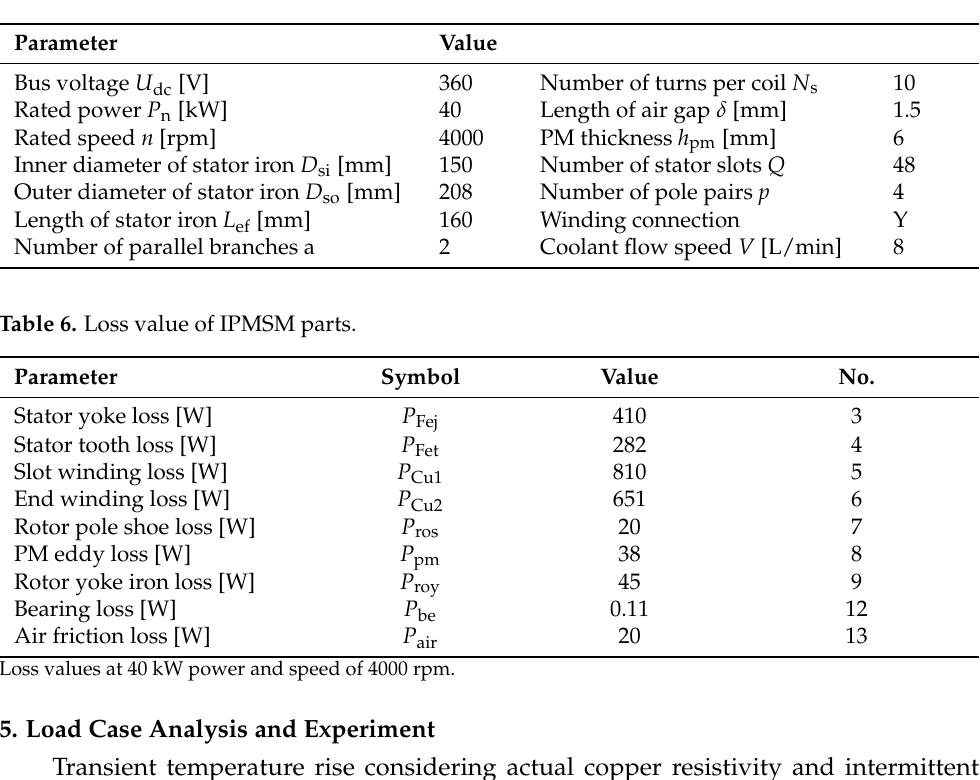
Table 5. IPMSM Dimensions and Parameters.